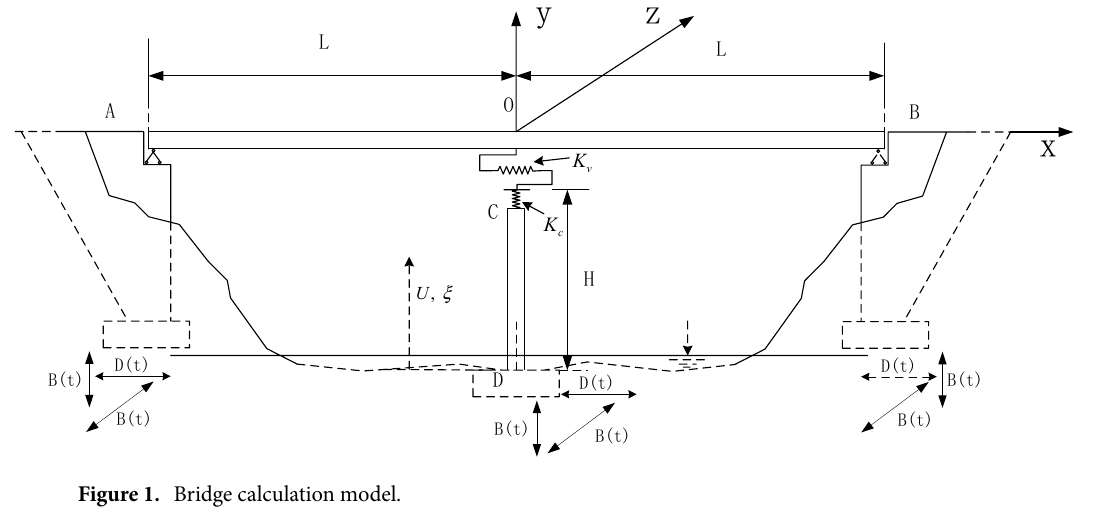
Figure 1. Bridge calculation